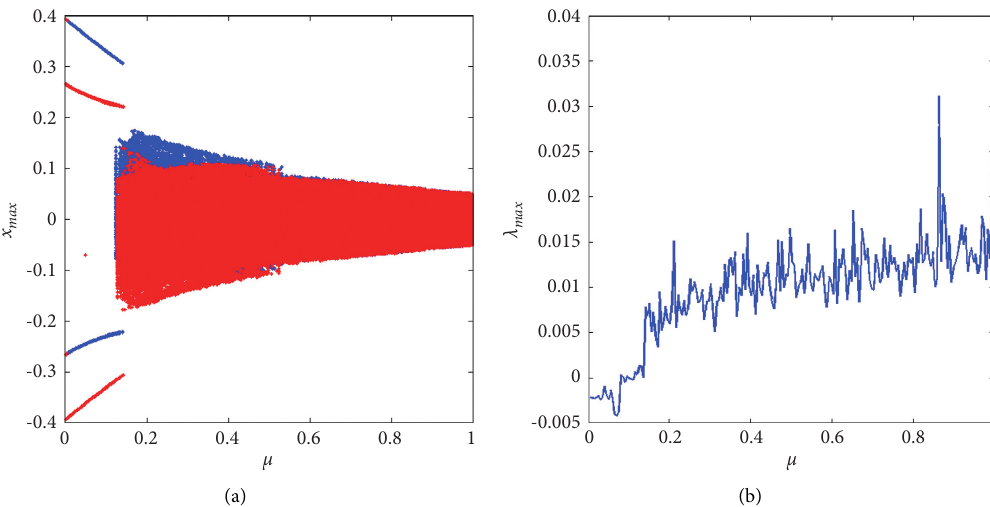
Figure 7: Bifurcation and maximum LE of system (8) versus μ depicted in (a) and (b), respectively, for parameters A � 0 . 05 , B � 0 , C � 1, and two symmetric initial conditions ( x